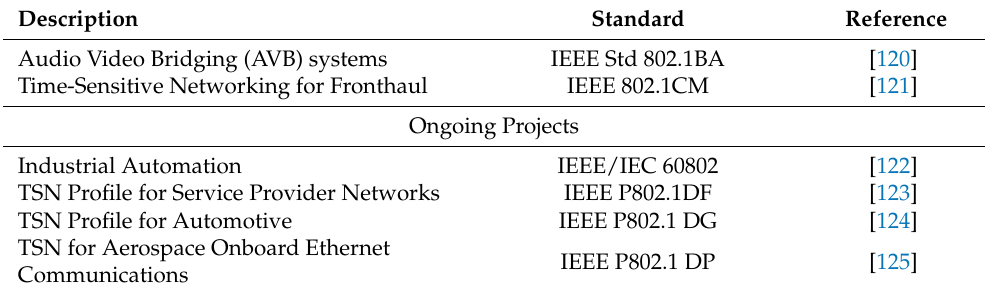
Table 3. TSN profiles.